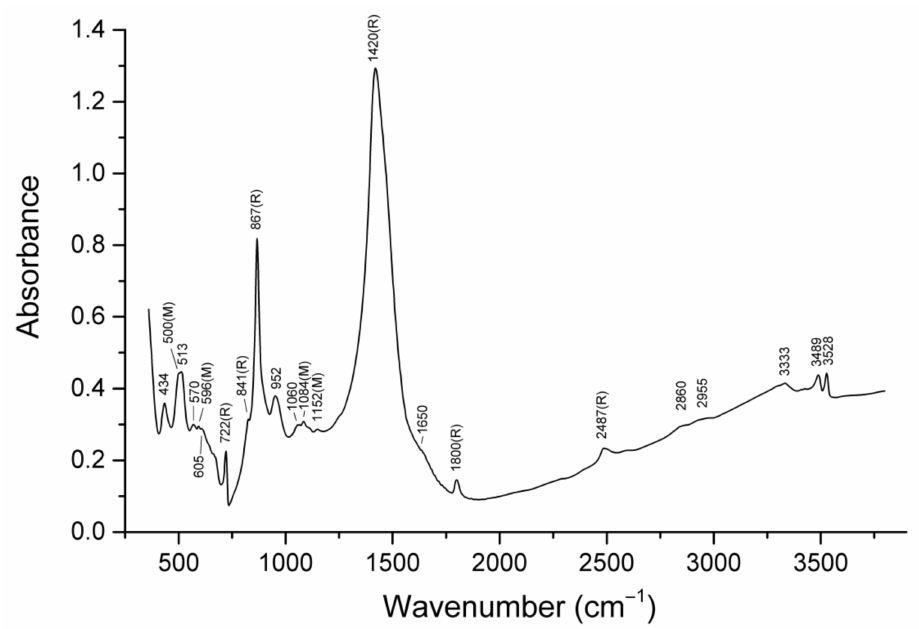
Figure 4. Infrared spectrum of a mixture of feitknechtite with rhodochrosite (R) and manganite (M) from the Zmeinogorskoe deposit, South Urals,